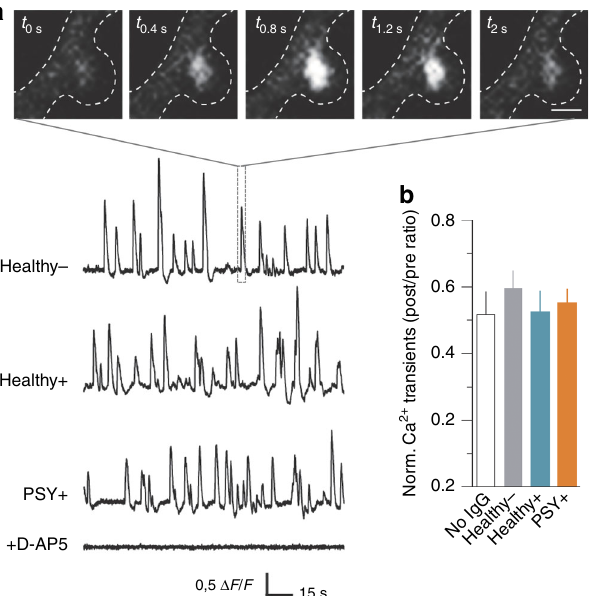
Fig. 7 NMDAR-Ab from Healthy + subjects and PSY + patients do not affect NMDAR-mediated Ca 2+ transients in spines of hippocampal neurons. a Representative time-lapse images of a spontaneous NMDAR-mediated Ca 2 + transient in basal condition (in the presence of nifedipine 5 µ M and bicuculline 5 µ M). Scale bar, 2 µ m. Lower panel, representative examples of NMDAR-mediated Ca 2+ transients recorded in spines (expressed as Δ F / F ratio) exposed to puri fi ed IgG from Healthy − , Healthy +, or PSY + individuals. Note that all events were abolished by the NMDAR-competitive antagonist D-AP5 (50 µ M). b Normalized frequency (ratio of Ca 2+ transients frequency post-application of NMDAR-Ab relative to the baseline acquisition) of spontaneous NMDAR-mediated Ca 2+ transients in control condition with no IgG ( n = 38 spines, N = 4 neurons) or in the presence of Healthy − puri fi ed IgG ( n = 38, N = 5), Healthy + NMDAR-Ab ( n = 68, N = 10), or PSY + NMDAR-Ab ( n = 131, N = 15). Data are expressed as mean ± SEM. One out of one Healthy − , three out of three Healthy + , and four out of nine PSY + were used and pooled for comparisons. P >